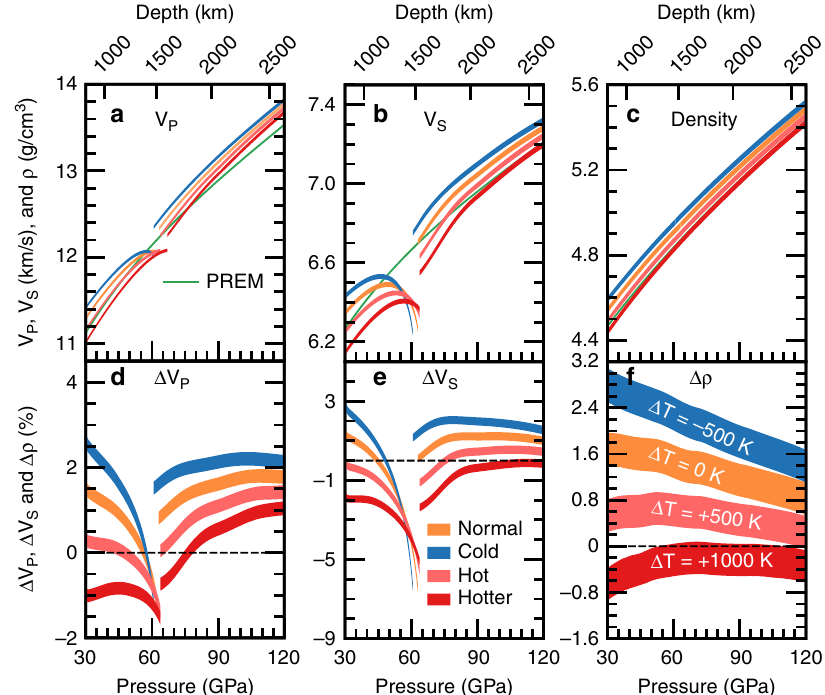
Fig. 4 Velocities and density characteristics of subducted oceanic crust. a – c Wave velocities (V P and V S ) and densities ( ρ ) of MORB along different mantle geotherms. The normal mantle geotherm is from Brown and Shankland (1981) 47 . Red, pink, orange, and blue lines represent V P , V S , and ρ of MORB along the mantle geotherms with variable temperature anomalies relative to the normal mantle geotherm. Temperature anomalies for red, pink, orange, and blue lines are + 1000 K, + 500 K, 0 K, and 500 K, respectively. Green lines are PREM values 69 . MORB 32 : 39% Fe- and Al-bearing bridgmanite (Mg 0.58 Fe 0.16 Al 0.26 Si 0.74 Al 0.26 O 3 ), 30% Ca-perovskite (CaSiO 3 ), 16% SiO 2 , and 15% Fe-bearing CF-type phase (Na 0.4 Mg 0.48 Fe 0.12 Al 1.6 Si 0.4 O 4 ). (d) (e) (f) the V P , V S , and ρ contrasts between MORB and PREM. Δ M = 2(M MORB -M PREM )/(M MORB + M PREM ), M = V P , V S , and ρ . M PREM , green lines in a , b , c ; M MORB , red, orange, or blue lines in a , b , c . The linewidth represents uncertainties caused by the errors for elastic properties (<0.8%) and the variations in the concentration of dilute substitutional solutes (±1 mol%).